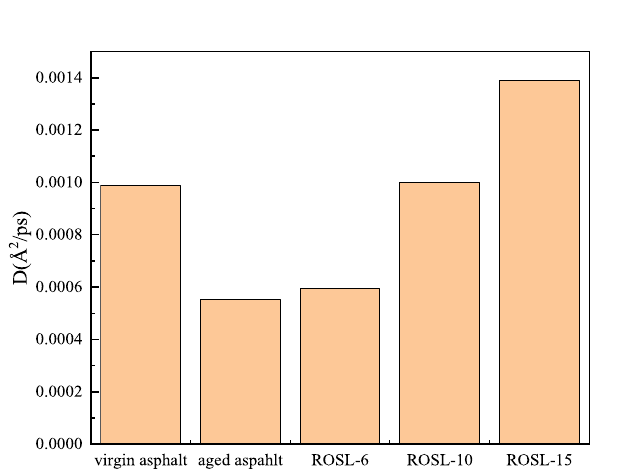
Figure 13. Average molecular diffusion coefficient of